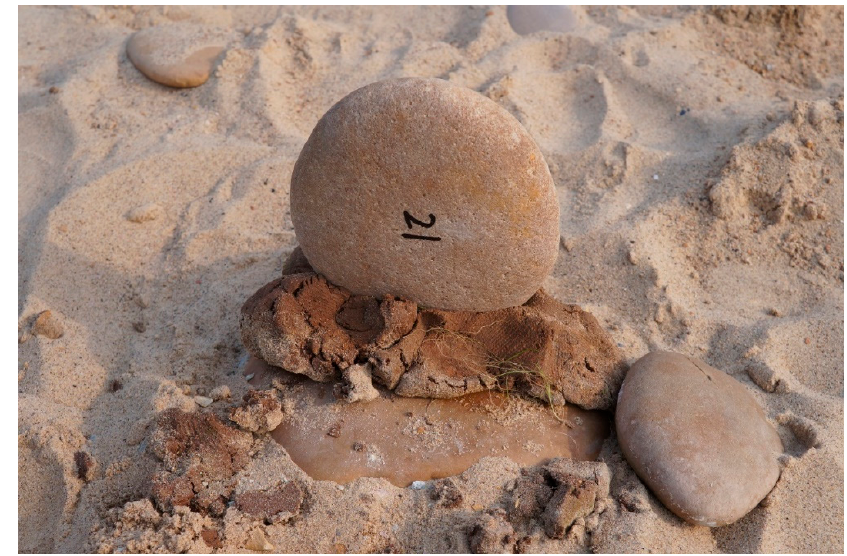
Figure 8. Wet mud fixing.